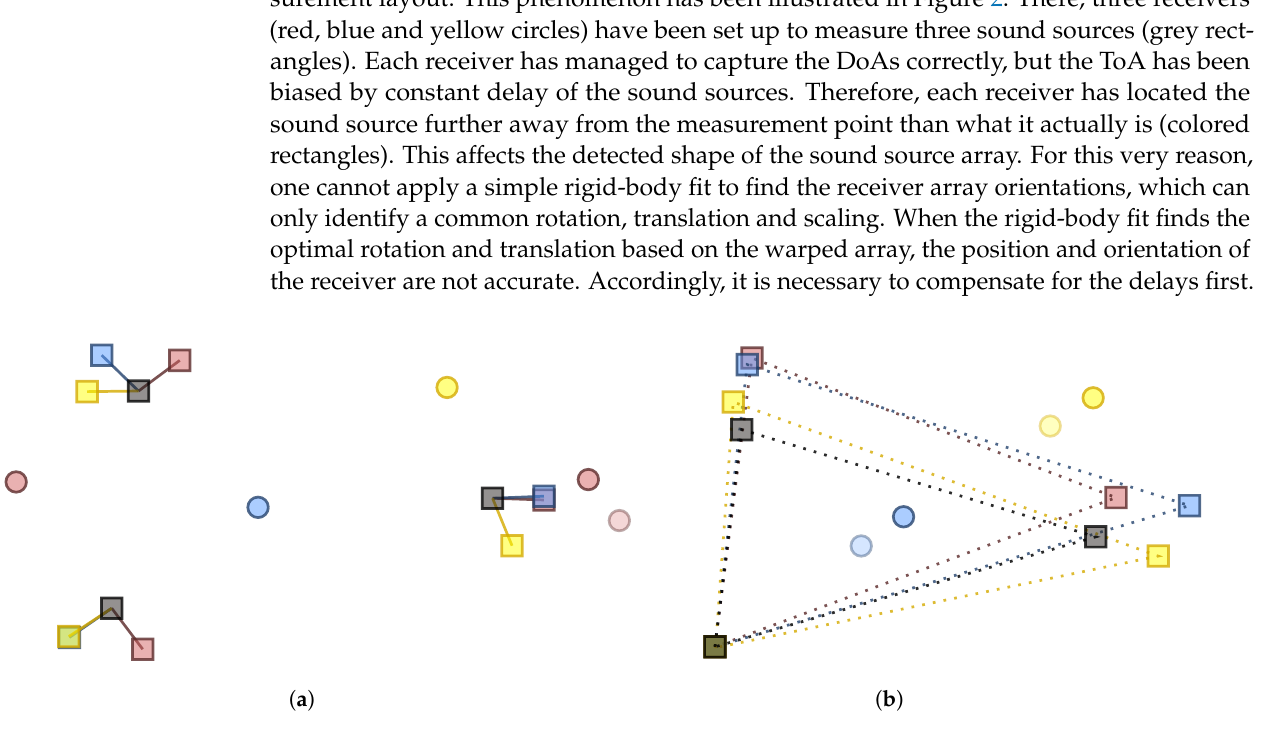
Figure 2. Source array distortion caused by a constant travel distance bias. ( a ) All loudspeakers (gray) have the same delay. When measured from three different receiver positions (red, blue, yellow circles), the detected position distorts differently. ( b ) When the detected positions are overlapped on one loudspeaker, one can distinguish geometry differences in the measured source